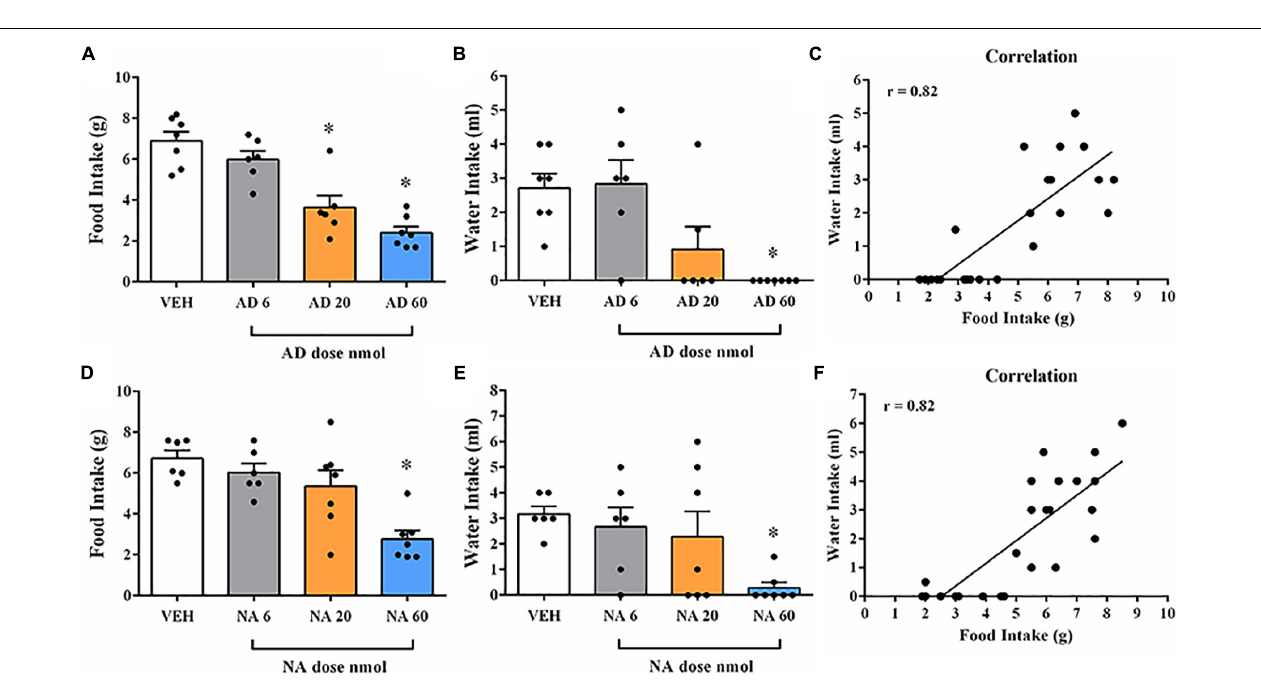
FIGURE 2 | Food and water intake after injection of adrenaline (AD) or noradrenaline (NA) into DR of fasted rats. (A) Changes in the amount of food intake after injection with vehicle (VEH) or AD at 6, 20, and 60 nmol doses into DR of fasted rats. (B) Changes in the amount of water intake after treatment with VEH or AD at 6, 20, and 60 nmol doses into DR of fasted rats. (C) Correlation between water and food intake after administration of AD (6, 20, 60 nmol) or VEH into DR. (D) Changes in the amount of food intake after injection with VEH or NA at 6, 20, and 60 nmol doses into DR of fasted rats. (E) Changes in the amount of water intake after injection with VEH or NA at 6, 20, and 60 nmol doses into DR of fasted rats. (F) Correlation between water and food intake after administration of NA (6, 20, 60 nmol) or VEH into DR. In all experiments, separate rats were used for each dose; each rat received only a single injection of drug or vehicle. Data represent the mean ± SEM * p < 0.05 vs. vehicle group. One-way ANOVA followed by Tukey’s post hoc test ( n = 6–8 per group). Pearson’s correlation test * p < 0.05.